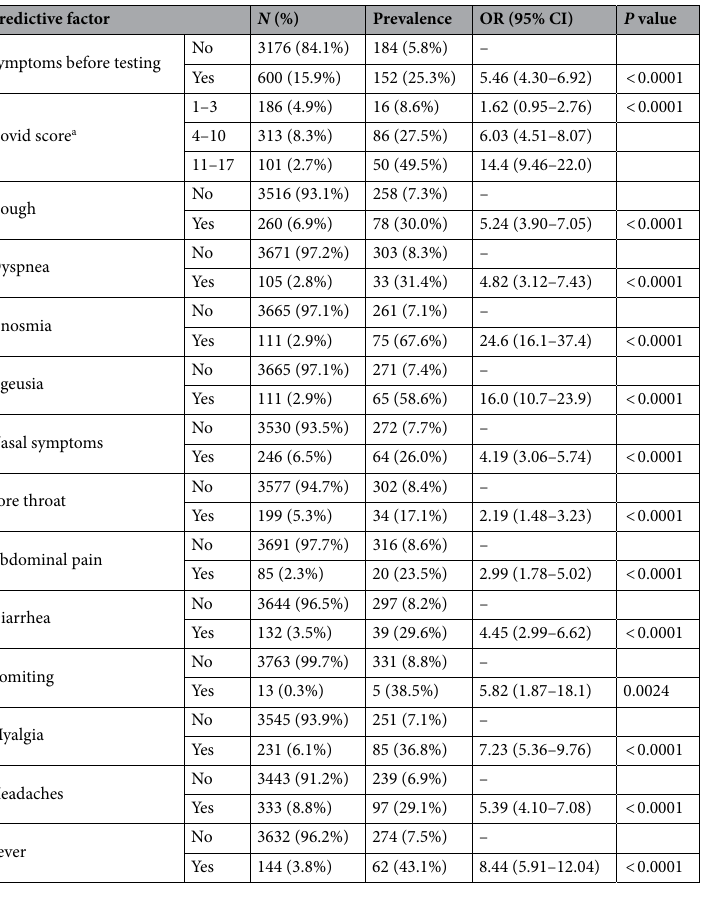
Table 3. Predictors of SARS-Cov-2 positive serology (IgG DiaSorin) in phase 1: symptoms. OR = odds ratio of univariate logistic regression models adjusted for time between March 1 and testing; CI = confidence interval. a COVID-19 score: cough or dyspnea = 4 points; anosmia or ageusia = 4 points; nasal symptoms or sore throat = 1 point; abdominal pain, diarrhea or vomiting = 1 point; myalgia = 1 point; headaches = 2 points; fever < 38 °C = 1 point or fever ≥ 38 °C = 4